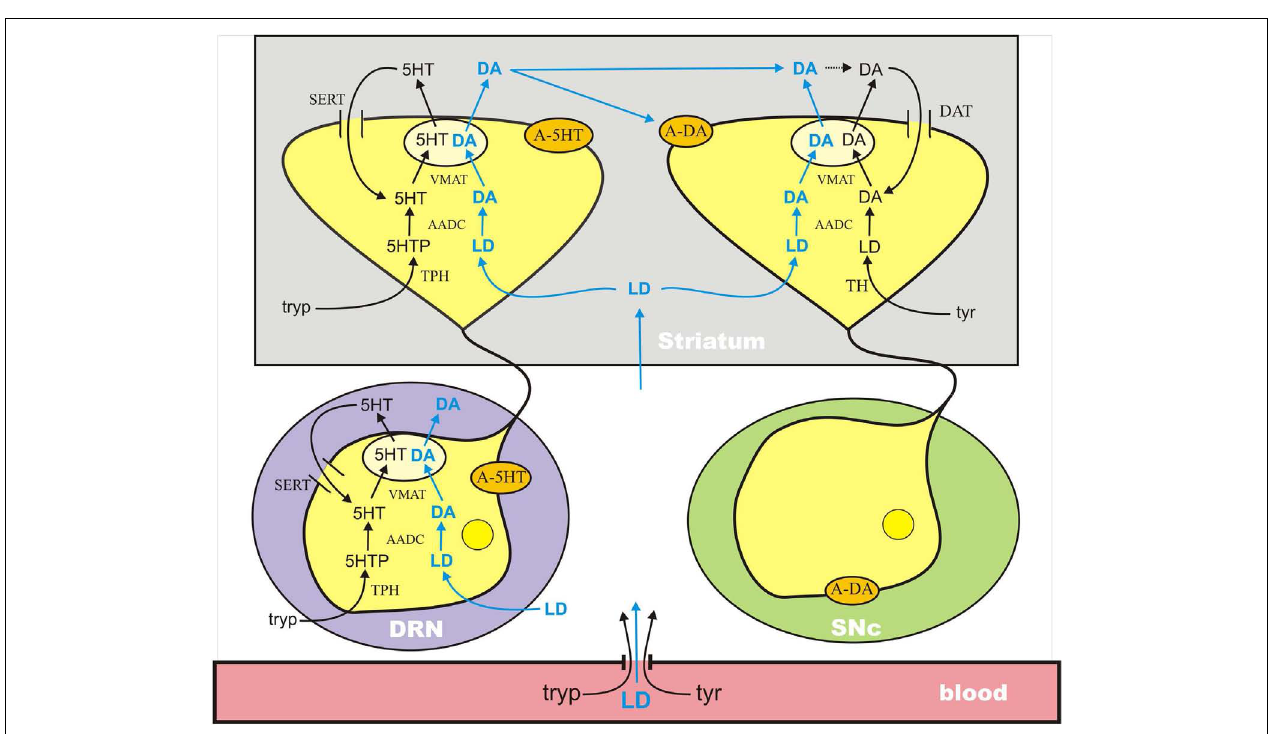
et al., 2010b) in the striatum and adds a model for the serotonergic cell body in the DRN. See the Discussion in the text. A-5HT and A-DA indicate 5HT and DA autoreceptors, respectively. Full details are available in the